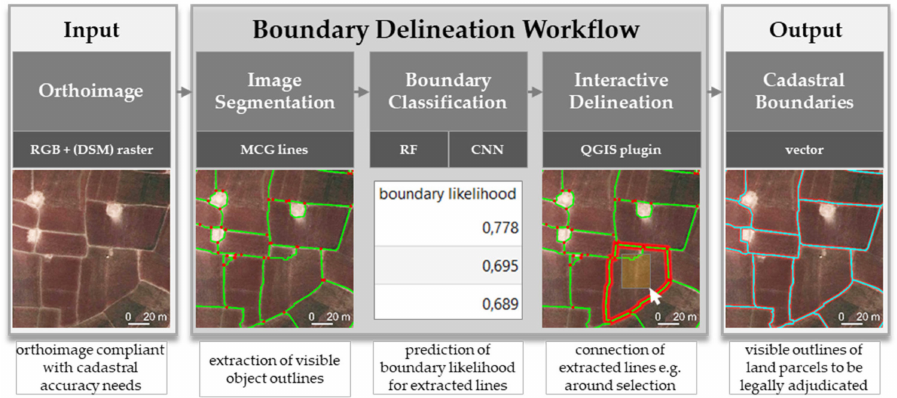
Figure1. BoundaryDelineationworkflowproposedtoimproveindirectsurveying. Thisstudyoptimizes image segmentation, questions whether Random Forest (RF) or Convolutional Neural Networks